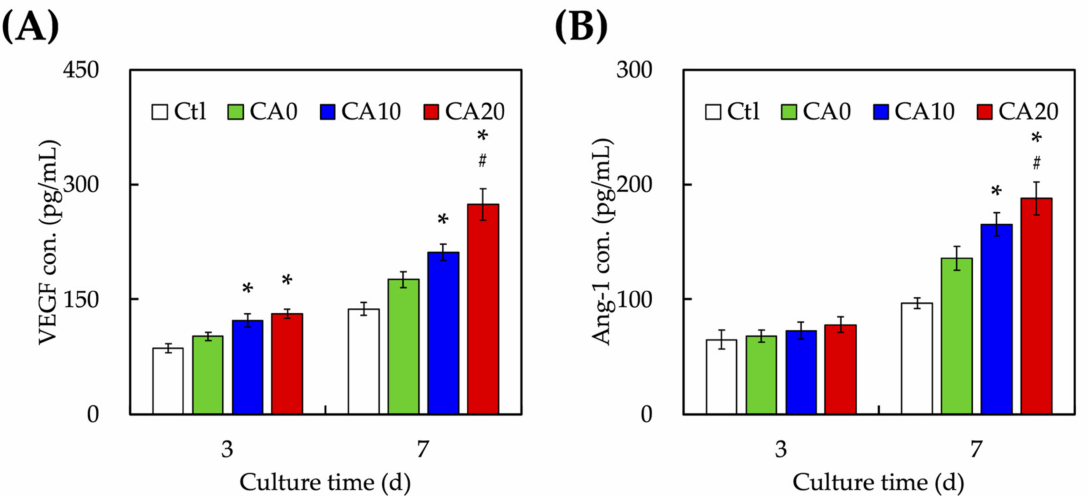
Figure 7. Angiogenesis-related differentiation markers of ( A ) VEGF and ( B ) Ang-1 expression of hDPSCs cultured on CA0, CA10, and CA20 scaffolds for different time points. * indicates a significant difference ( p < 0.05) from CA0. # indicates a significant difference ( p < 0.05) from CA10. Data presented as mean ± SEM; n = 6 for each